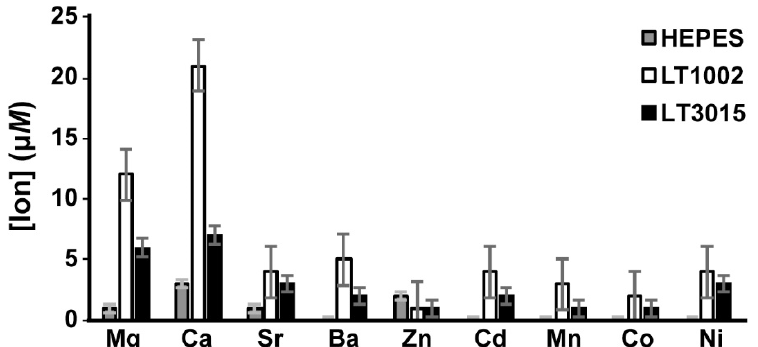
Figure 4. Average metal ion concentrations after 24 h of dialysis in the presence of Na-HEPES buffer alone (grey), LT1002 anti-S1P antibody (white), or control LT3015 anti-LPA antibody. Triplicate samples were analyzed by ICP-MS.